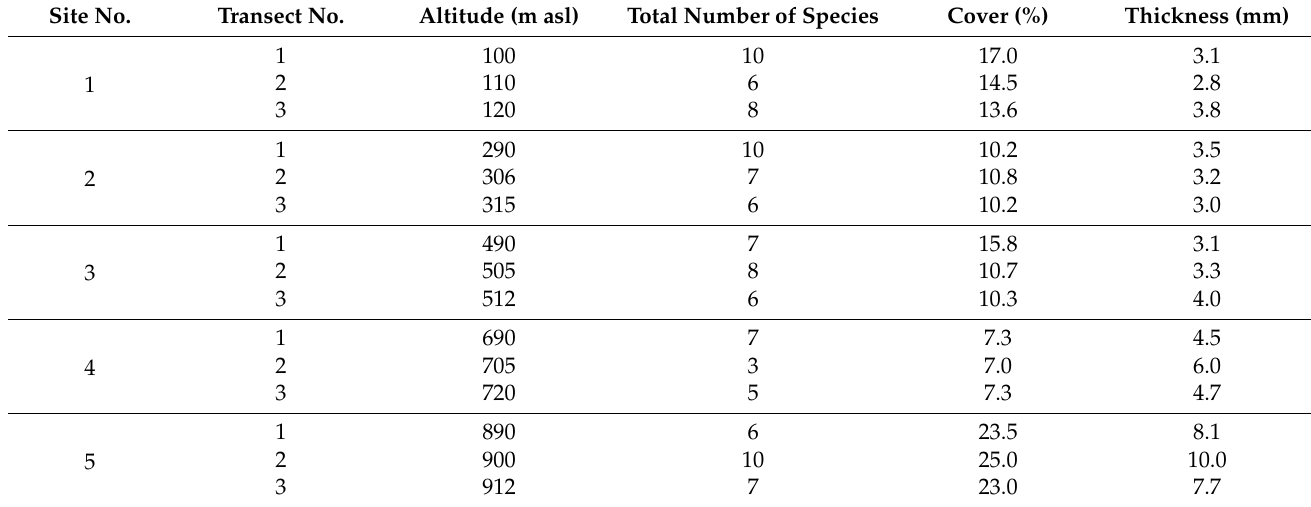
Table A2. Composition and distribution of terrestrial mosses along the altitudinal gradient ( n = 6). Site No.